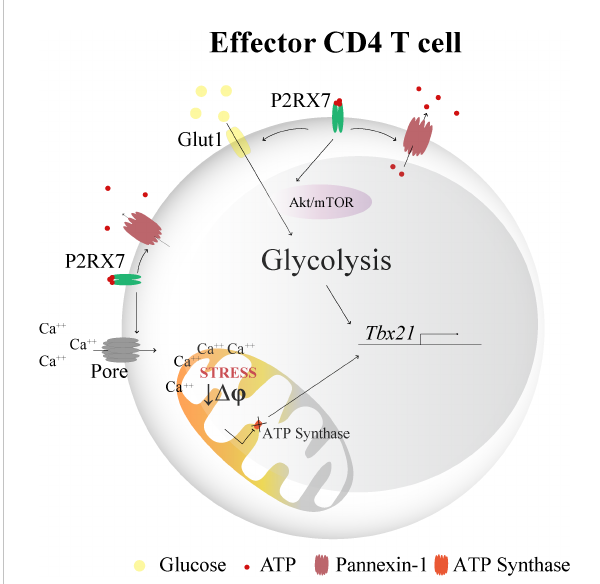
FIGURE 5 Schematic illustration showing the hypothetical role of P2RX7 in Th1 differentiation through metabolic reprogramming. High extracellular ATP concentrations activate P2RX7 in CD4 + T cells under stress conditions during in fl ammation. The intracellular ATP may be released to the extracellular space through pannexin-1 (Panx1) channels and maintain autocrine purinergic activation. P2RX7 signaling induces metabolic reprogramming required for the Th1 response by increasing the expression of phosphorylated mTOR and Akt, glucose uptake and glycolytic enzymes, which culminates in T- bet transcription. In addition, P2RX7-dependent pore formation promotes intense Ca ++ in fl ux (8), leading to mitochondrial stress and membrane potential reduction ( Dy ). ATP synthase inhibition is likely a downstream effect of P2RX7 signaling that potentiates the Th1 response, as drug-induced blockade of this enzyme restores Th1 differentiation in the absence of P2RX7. Thus. a possible connection between P2RX7-mediated mitochondrial effects and T- bet upregulation is that P2RX7 signaling in CD4 + T cells induces ATP synthase inhibitors that promote the metabolic shift required to sustain the Th1